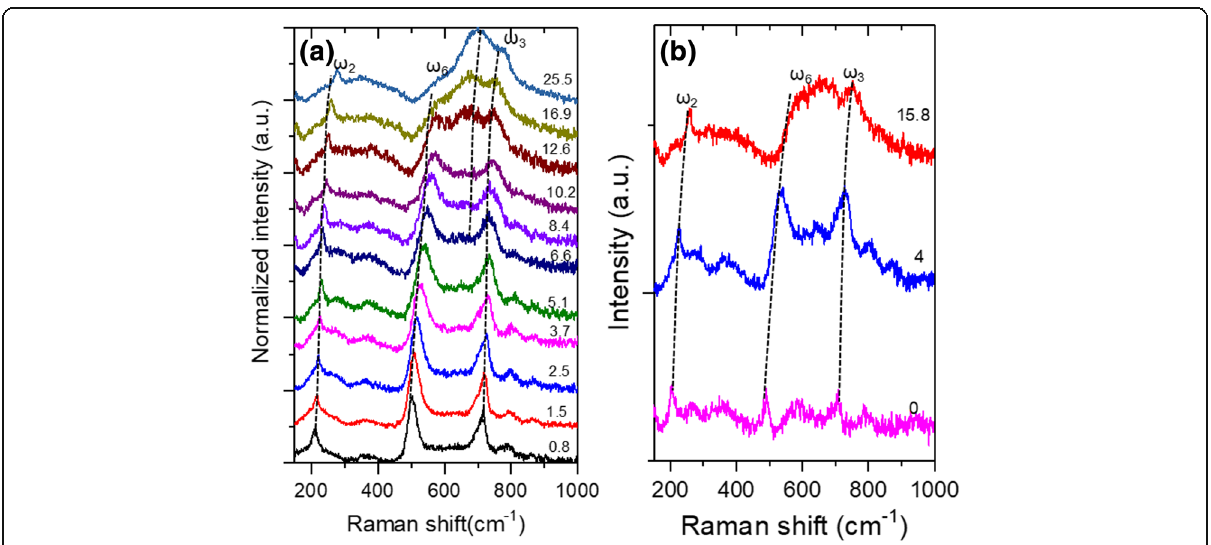
Fig. 3 a Raman spectra of Ti 3 C 2 T x flakes at different compression pressures; b Raman spectra obtained at different decompression pressures. Note that the unit of pressures in a and b is